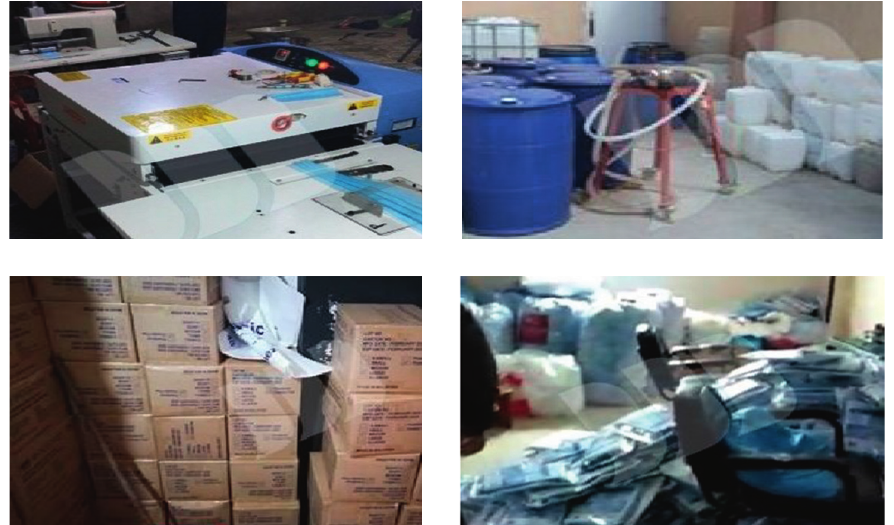
Figure 20: Medical stock [25].